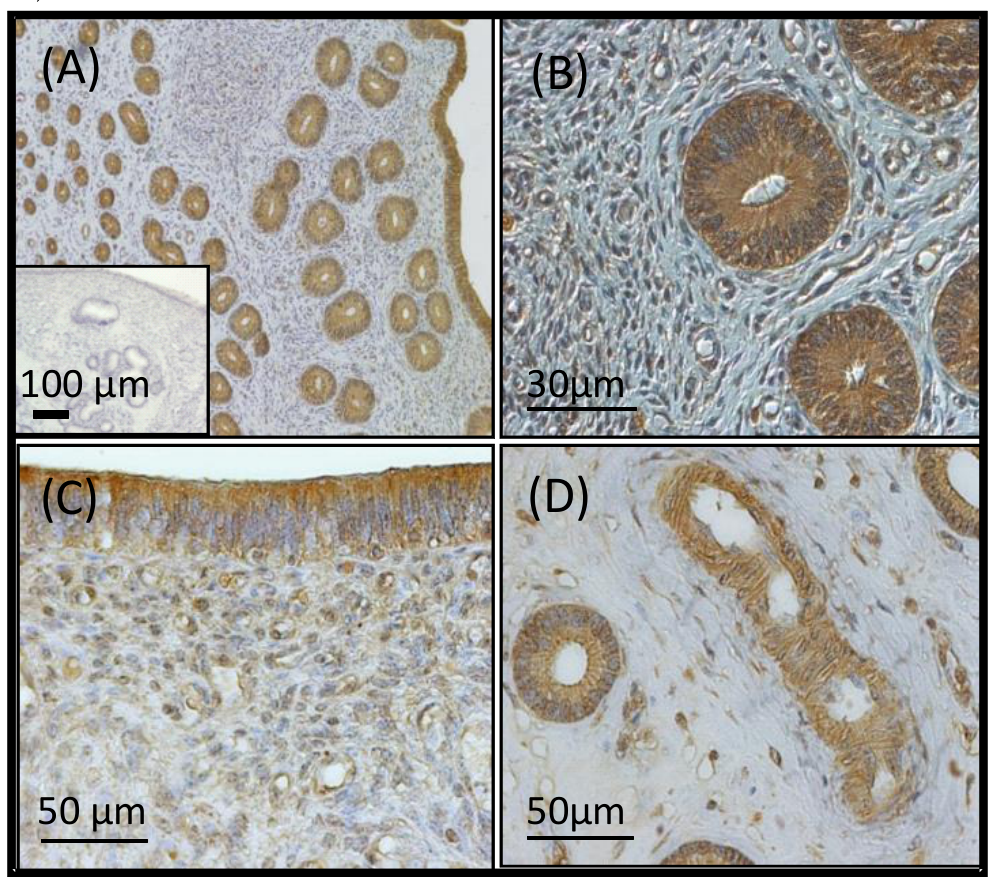
Figure 2. VEGFA immunohistochemistry: an overview of the endometrium ( A ) and close-up views of an endometrial gland ( B ), the luminal epithelium ( C ) and a blood vessel ( D ). Insert ( A ) displays the negative control where serum was used instead of the primary antibody. All cells stained positive for vascular endothelial growth factor A without differing in intensity over time between pregnant and nonpregnant heifers.